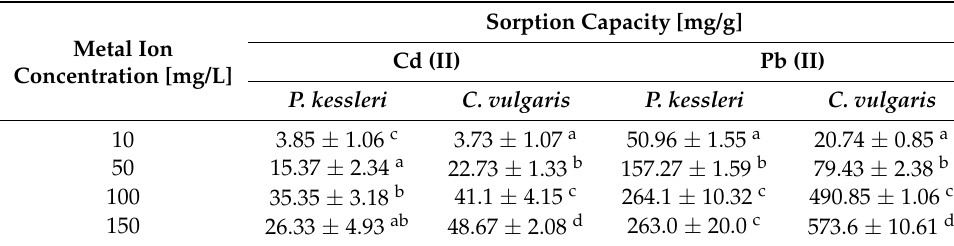
Table 4. Sorption capacity of EPS synthesized by P. kessleri and C. vulgaris toward Cd (II) and Pb (II). The superscript letters (a, ab, b, c, and d) in the table indicate statistical significance of the pre-